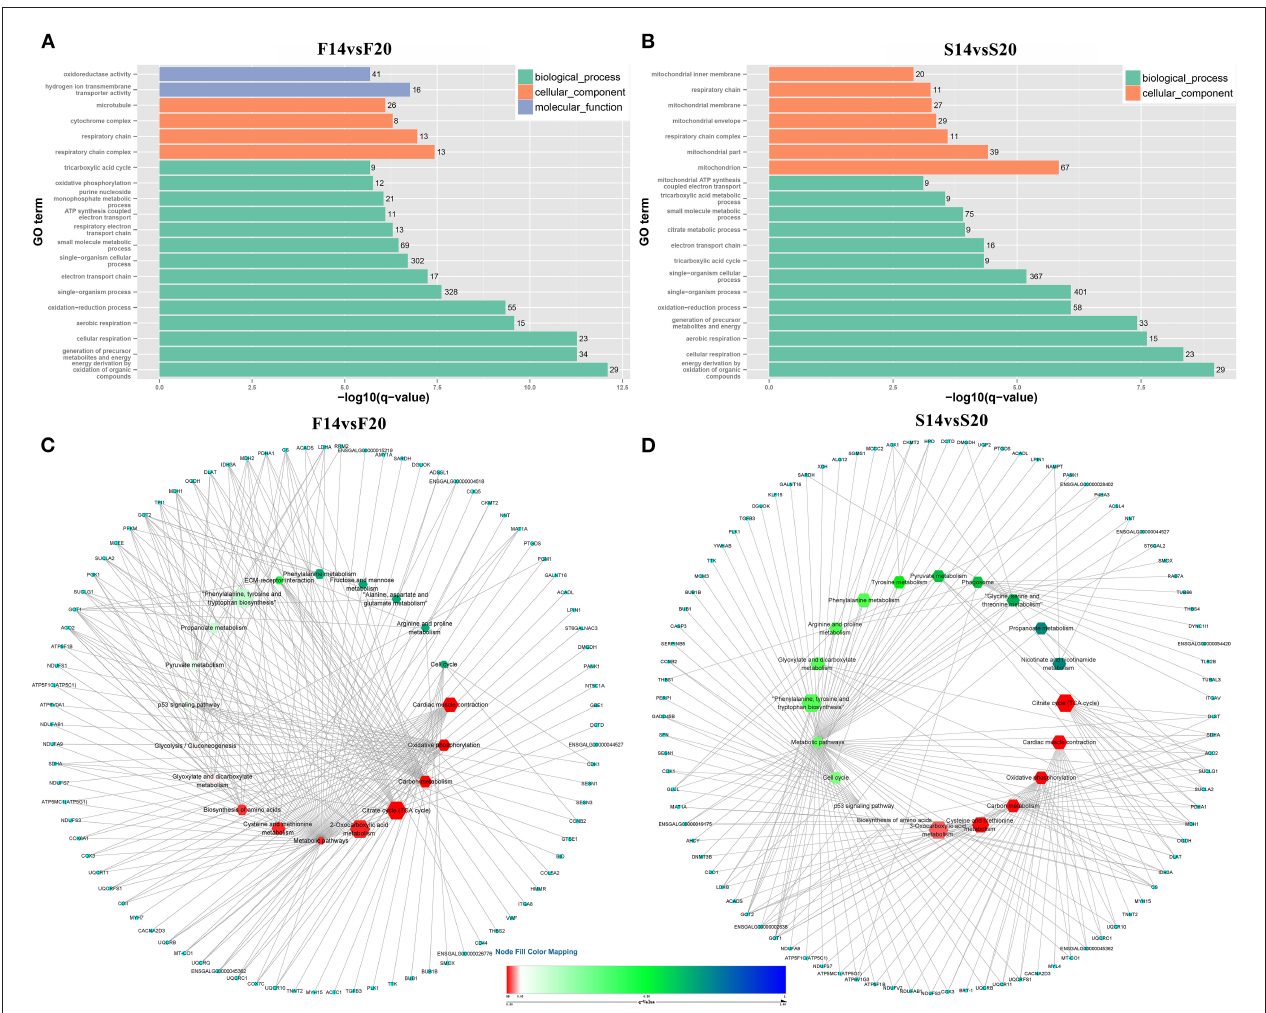
FIGURE 6 | Functional enrichment analysis of targeted DE mRNAs (A) GO enrichment analysis for targeted DE mRNAs of F14vsF20; (B) GO enrichment analysis for targeted DE mRNAs of S14vsS20; (C) KEGG pathway enrichment for targeted DE mRNAs of F14vsF20; (D) KEGG pathway enrichment for targeted DE mRNAs of S14vsS20. (C,D) The hexagon of the inner ring represents the pathways, and the circle of the outer ring represents the enriched